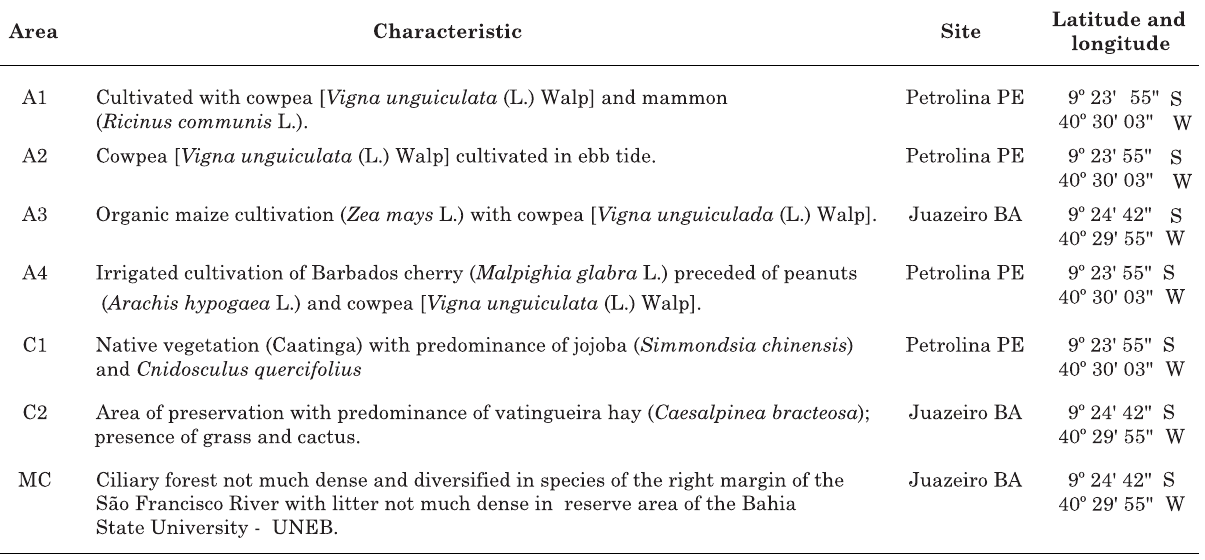
Table 1. Location and characteristics of the areas sampled in two municipalities of the lower half of the São Francisco river valley